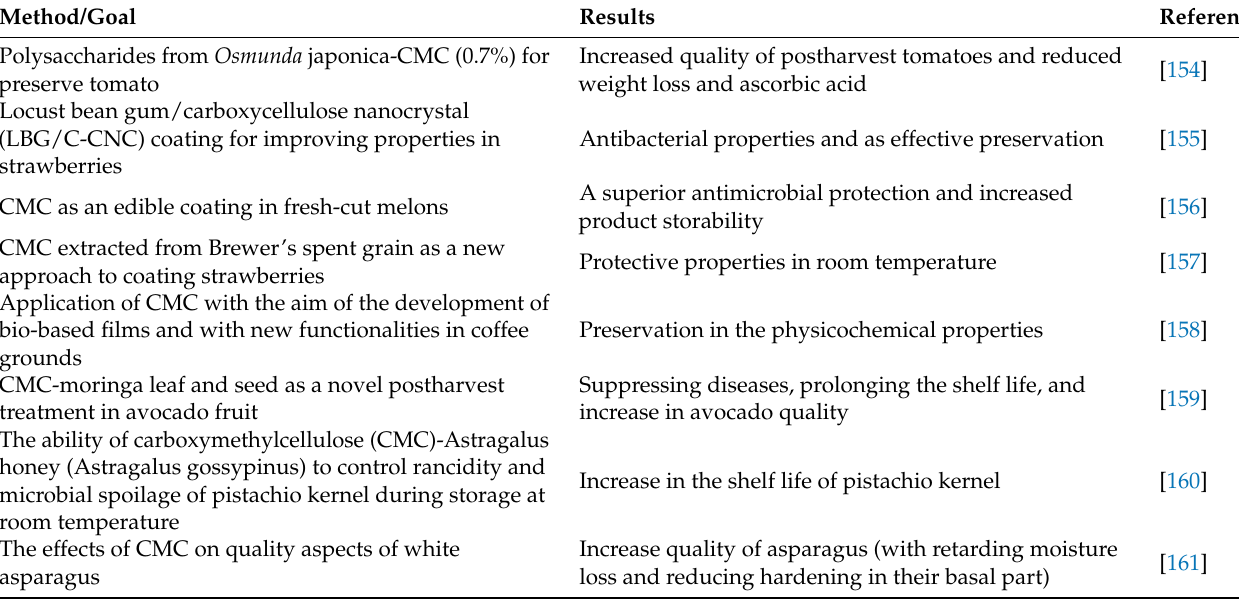
Table 7. CMC edible coating in preservation of agricultural